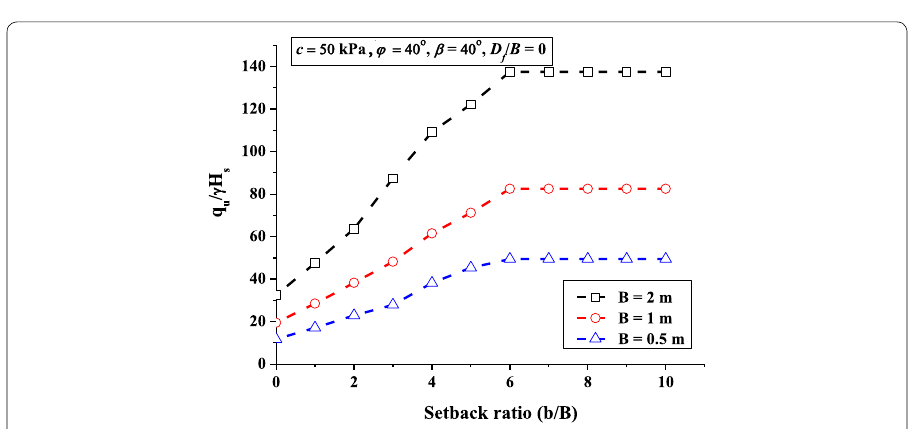
Fig. 11 Typical variation of q u / γH s with footing width ( B ) and setback ratio ( b/B